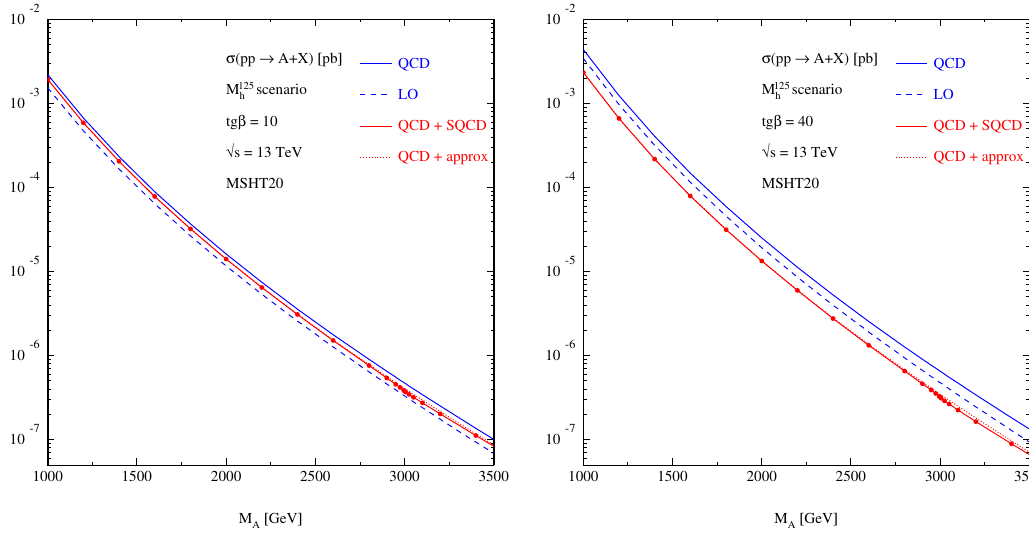
Figure 10 . The pseudoscalar production cross section via gluon-fusion at the LHC with tg β = 10 (left) and tg β = 40 (right) and a c.m. energy of 13 TeV at LO, NLO QCD and including the genuine SUSY-QCD corrections involving effective Yukawa couplings. The LO and NLO QCD corrected cross sections are shown without effective Yukawa couplings. As parton density functions the MSHT20 sets have been used. The renormalization and factorization scales have been chosen as µ R = µ F = M A / 2